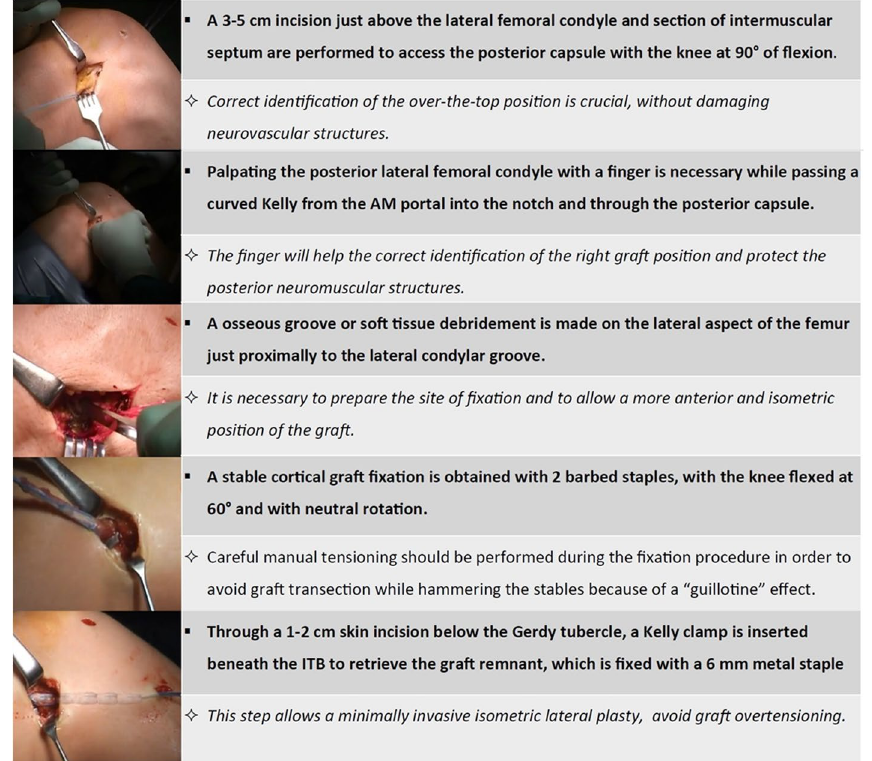
Fig. 5 Technical tips for over-the-top and lateral plasty ACL